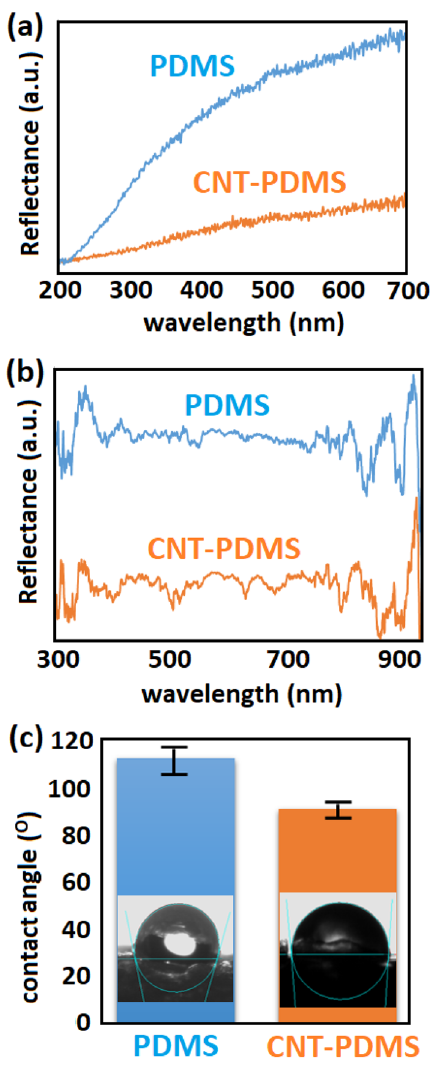
Figure 3. Characterization of fabricated foams. UV–Vis ( a ), DRS ( b ), and contact angle ( c )